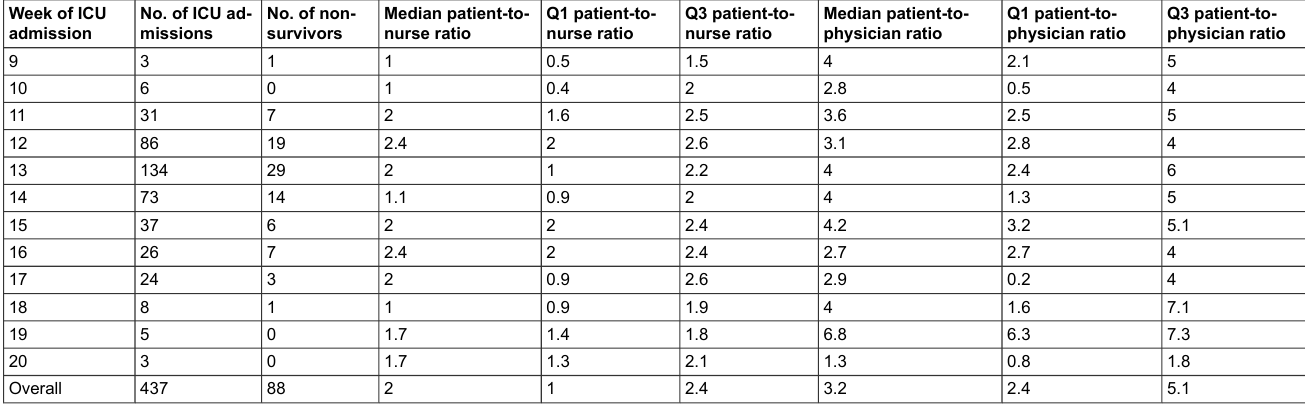
Table S3: Admission characteristics, by week of ICU